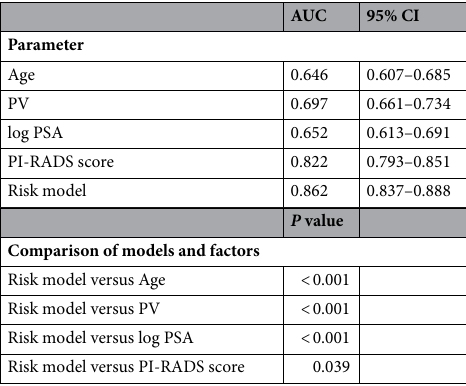
Table 3. AUC of ROC curve analysis for the performance of age, PV, PSA, PI-RADS and risk model to sPC, and DeLong test for model and factors comparison. AUC area under the curve, CI confidence interval, PI-RADS prostate imaging reporting and data system, PSA prostate-specific antigen, PV prostate volume, ROC reciever operating characteristic, sPC clinically significant prostate cancer.